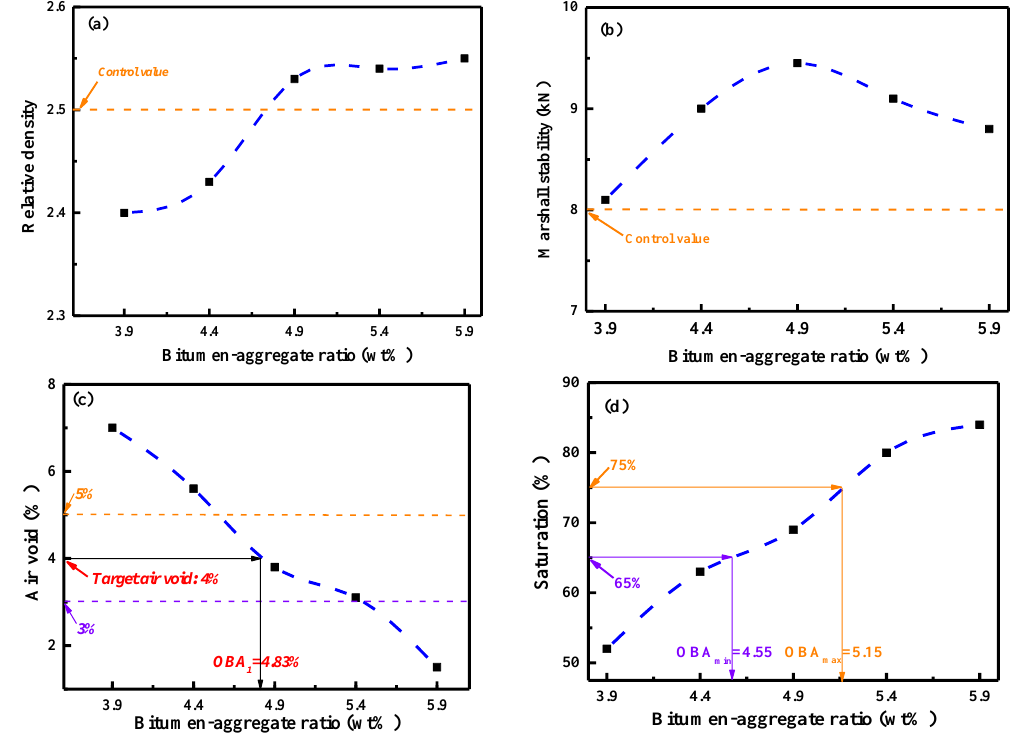
Figure 17. The influence of the bitumen – aggregate ratio on the basic properties of asphalt mixtures. According to the technical specifications of the AC-13 asphalt mixture, the relative density and Marshall stability should be larger than 2.50 and 8 kN, respectively [37]. In addition, the corresponding air void and saturation should be in 3 – 5% and 65 – 75%. There- fore, in this study, the optimum bitumen – aggregate ratio of control and recycled asphalt mixtures was calculated using Equation (10):